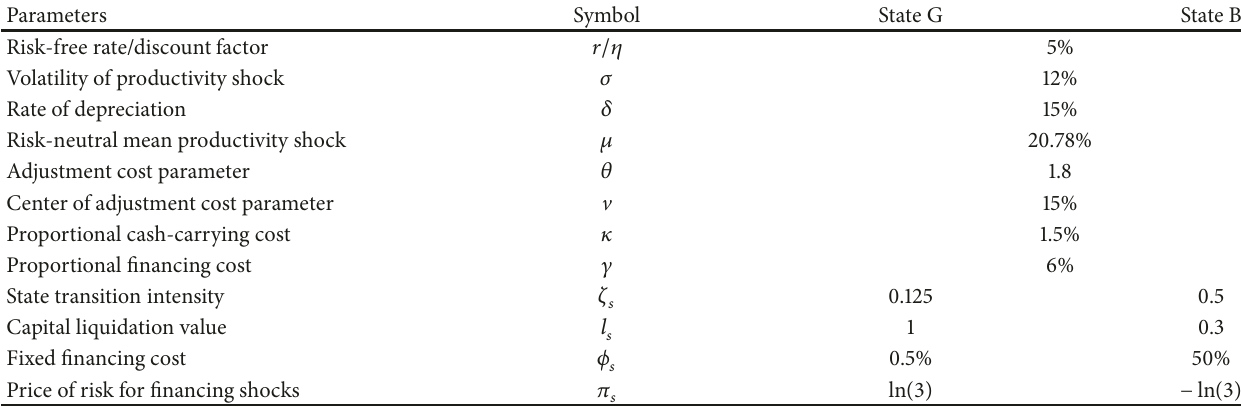
Table 1: Summary of the parameter